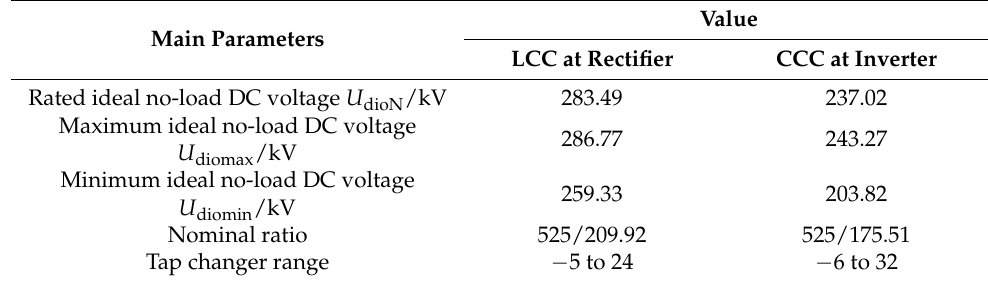
Table 5. Main parameters of the converter